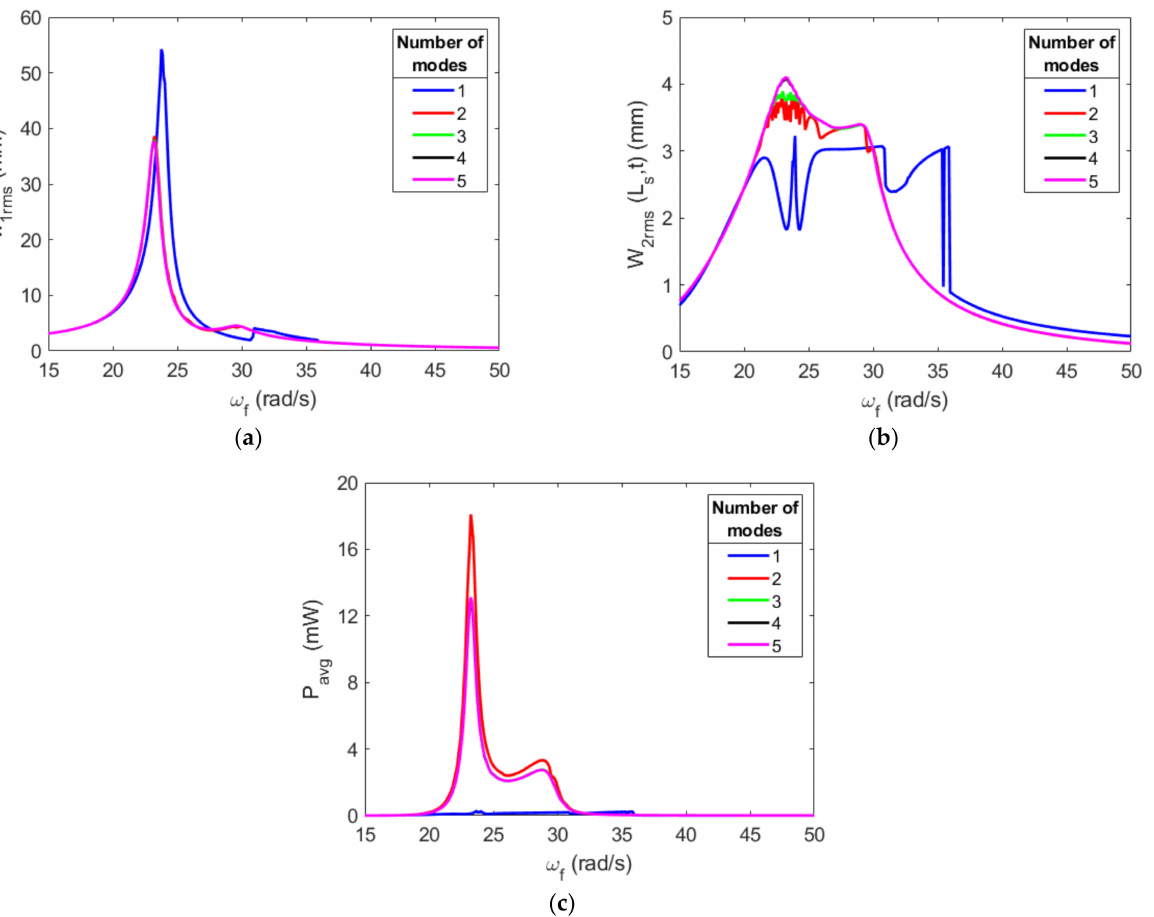
Figure 28. Modal convergence analysis for a forcing amplitude F 0 of 2 N , gap of M t of 5 mm , h s of 0.1397 mm and M t of 0.06 Kg for the ( a ) primary structure’s displacement, ( b ) absorber’s displacement and ( c ) energy